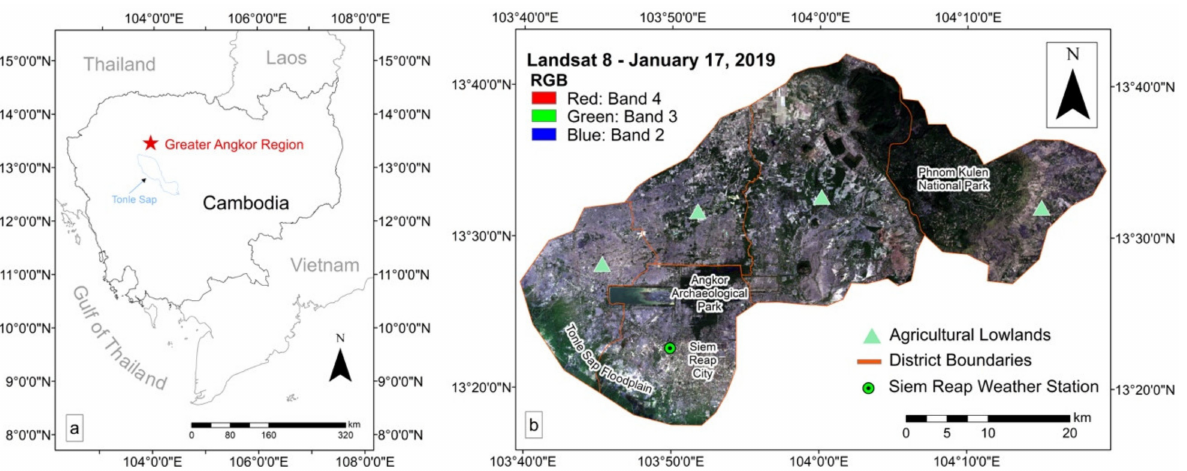
Figure 1. ( a ) Regional context depicting the study area in Cambodia ( b ) An RGB Landsat image highlighting important places and the location of the Siem Reap weather